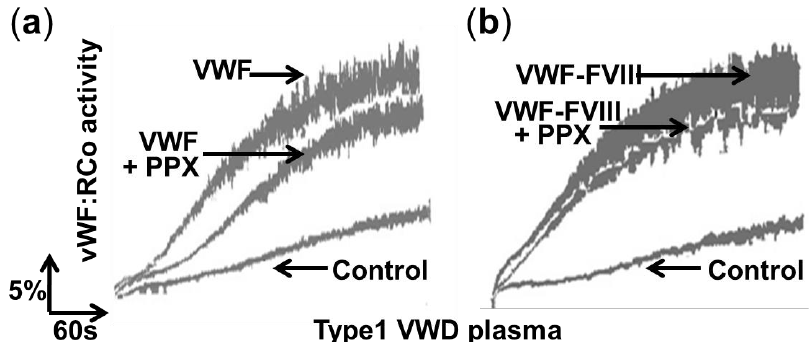
Figure 5. PolyP depletion does not affect von Willebrand factor ristocetin co-factor activity in the presence of factor VIII. Aggregation curves of fixed platelets in a ristocetin co-factor activity assay of plasma from patients with von Willebrand disease type 1. Prior to the assay, 50 µL of plasmas (diluted 1:2) were incubated for 10 min at 37 °C in the absence (control) or in the presence of 3.5 µg of von Willebrand factor (factor VIII-free) (VWF) ( a ) or von Willebrand factor co-purified with factor VIII (VWF – FVIII) ( b ). In addition, we performed similar plasma incubations but including 6.4 µg of recombinant yeast exopolyphosphatase (+PPX) ( a , b ). Measurements were performed using an optical platelet aggregometer (Chronolog Aggro-meter model 400). A representative experiment is shown (n = 3).